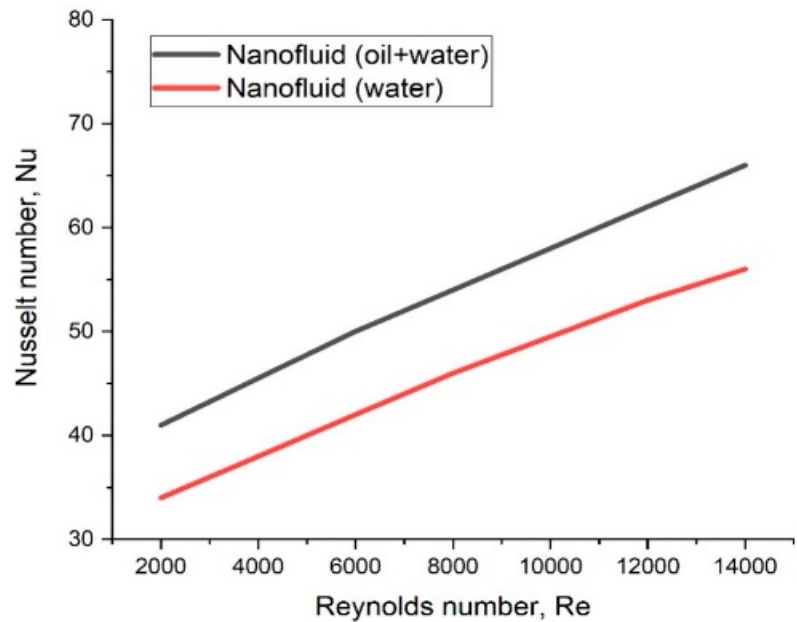
Figure 3. Comparison of 𝑁𝑢 vs. 𝑅𝑒 with water and oil + water-based nanofluids.